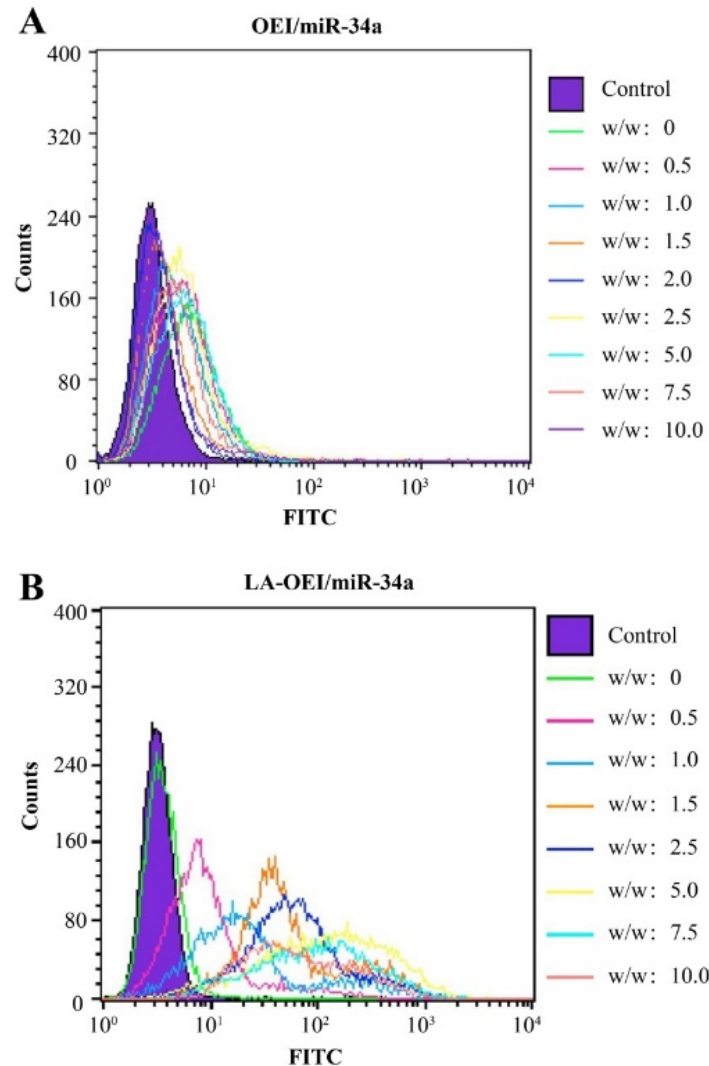
Figure 3. The transfection efficiency of nanoparticles at different mass ratios using FITC-labeled miR-34a. ( A ) OEI/miR-34a; ( B ) LA-OEI/miR-34a.